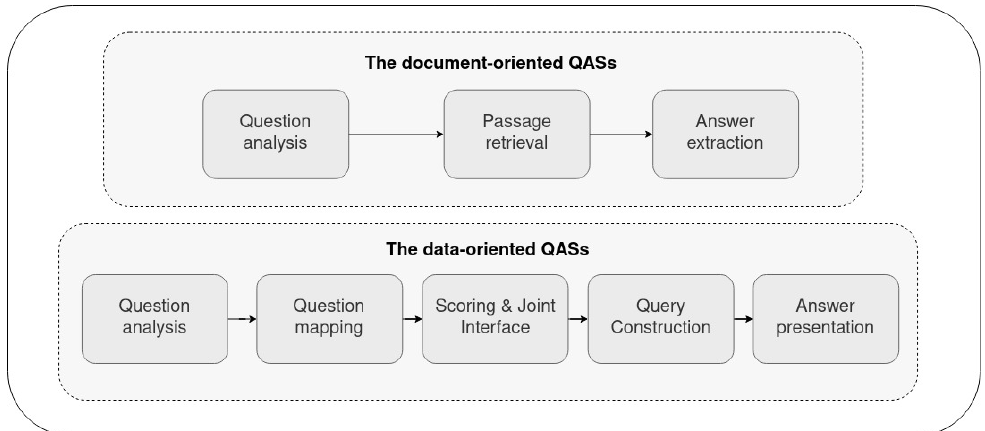
Figure 5. The document-oriented process